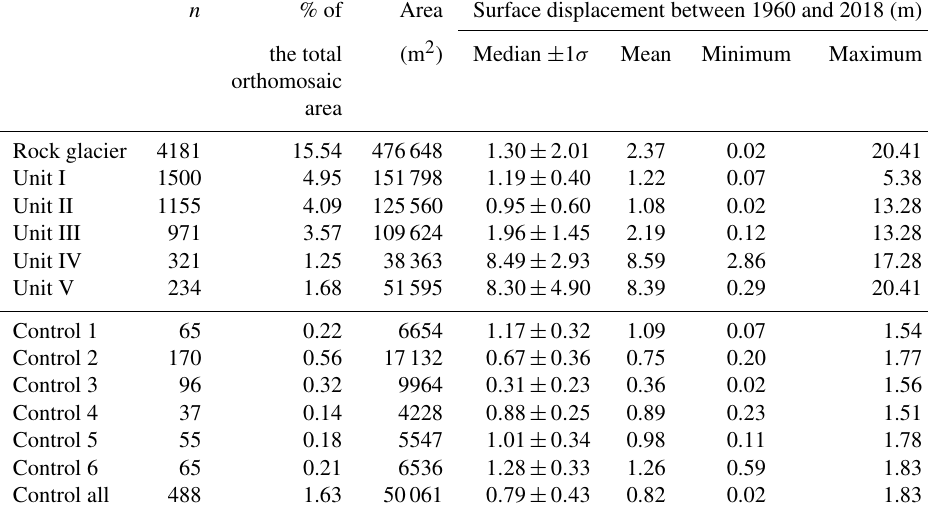
Table A3. Statistics of the rock glacier, units, and control areas from the IMCORR analysis. The total area of both orthomosaics